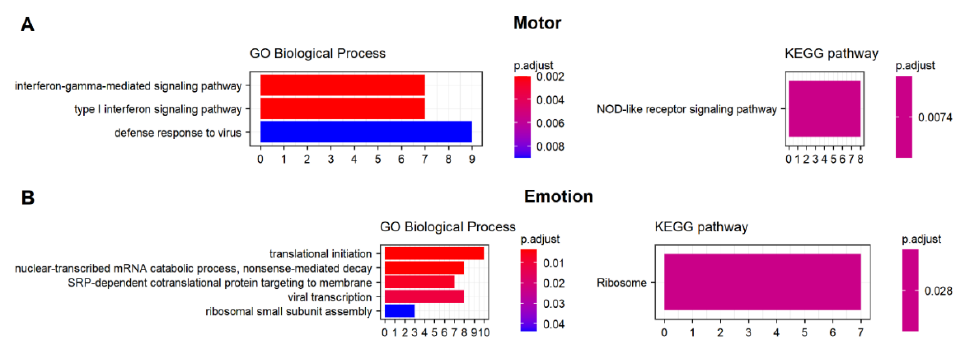
Figure 6. GO (biological process) and KEGG pathway enrichment analyses for the selected genes of the motor ( A ) and emotion ( B ) models. No enrichment was found in the cognition model. Cluster- Profiler analysis with BH-adjusted p -values < 0.05. Profiler analysis with BH-adjusted p -values <